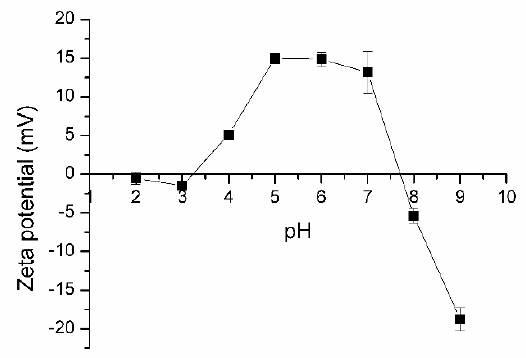
Figure 5. Effect of pH on the zeta potential measurement for ZnO 2 nanoparticles.